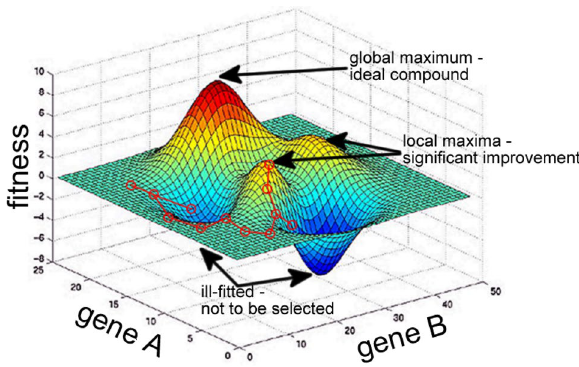
Fig. 3 A fitness landscape considering two hypothetical genes as, for example, block size and processing tem- perature of polymer synthesis. Fitness could be hardness, for instance. The landscape con- tains local maxima, a global maximum, and a global mini- mum. The path of a genetic algorithm along 11 iterations is shown in red. Elaborated by the authors of this